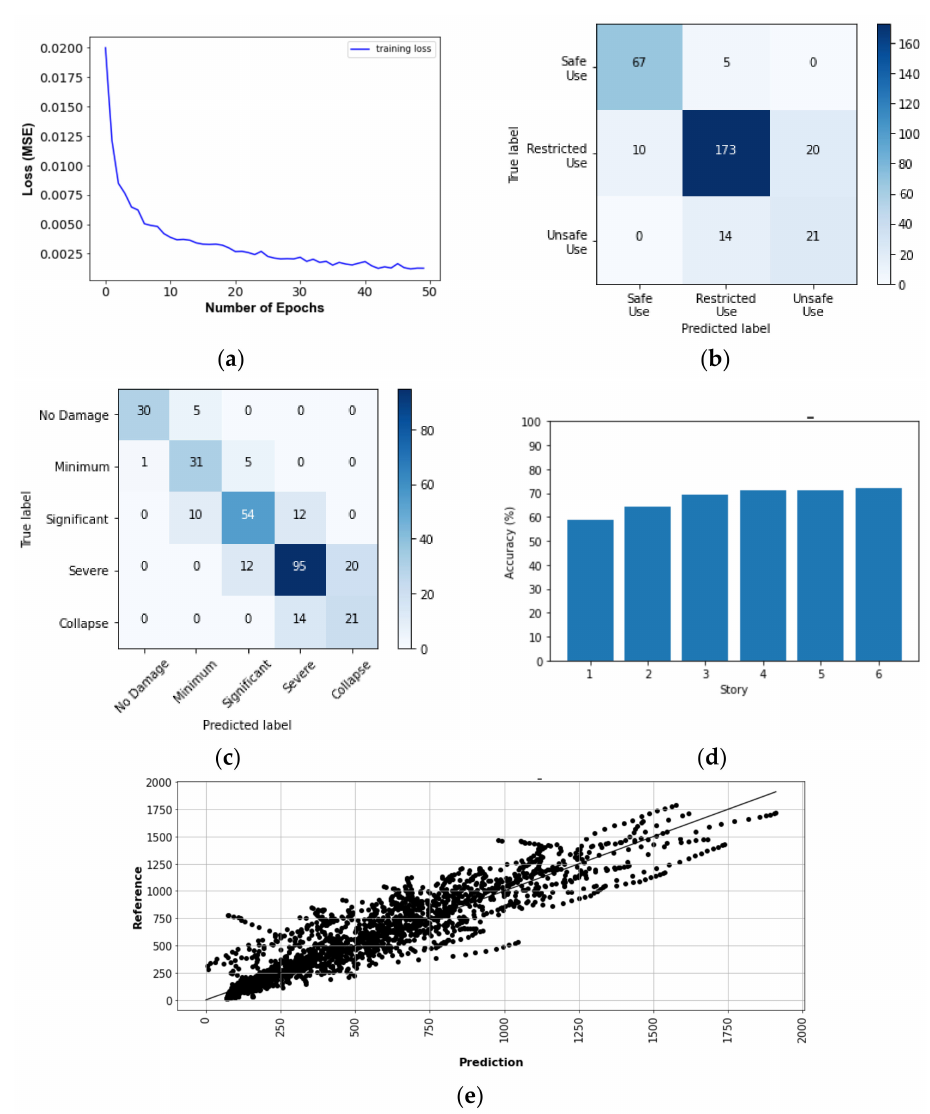
Figure 18. AA results of the TP and VP for Tahara City Hall building: ( a ) convergence curve—loss in the TP; ( b ) confusion matrix—usability of the building by VP; ( c ) confusion matrix—total damage condition by VP; ( d ) confusion matrix—storey damage condition by VP; ( e ) total comparison of